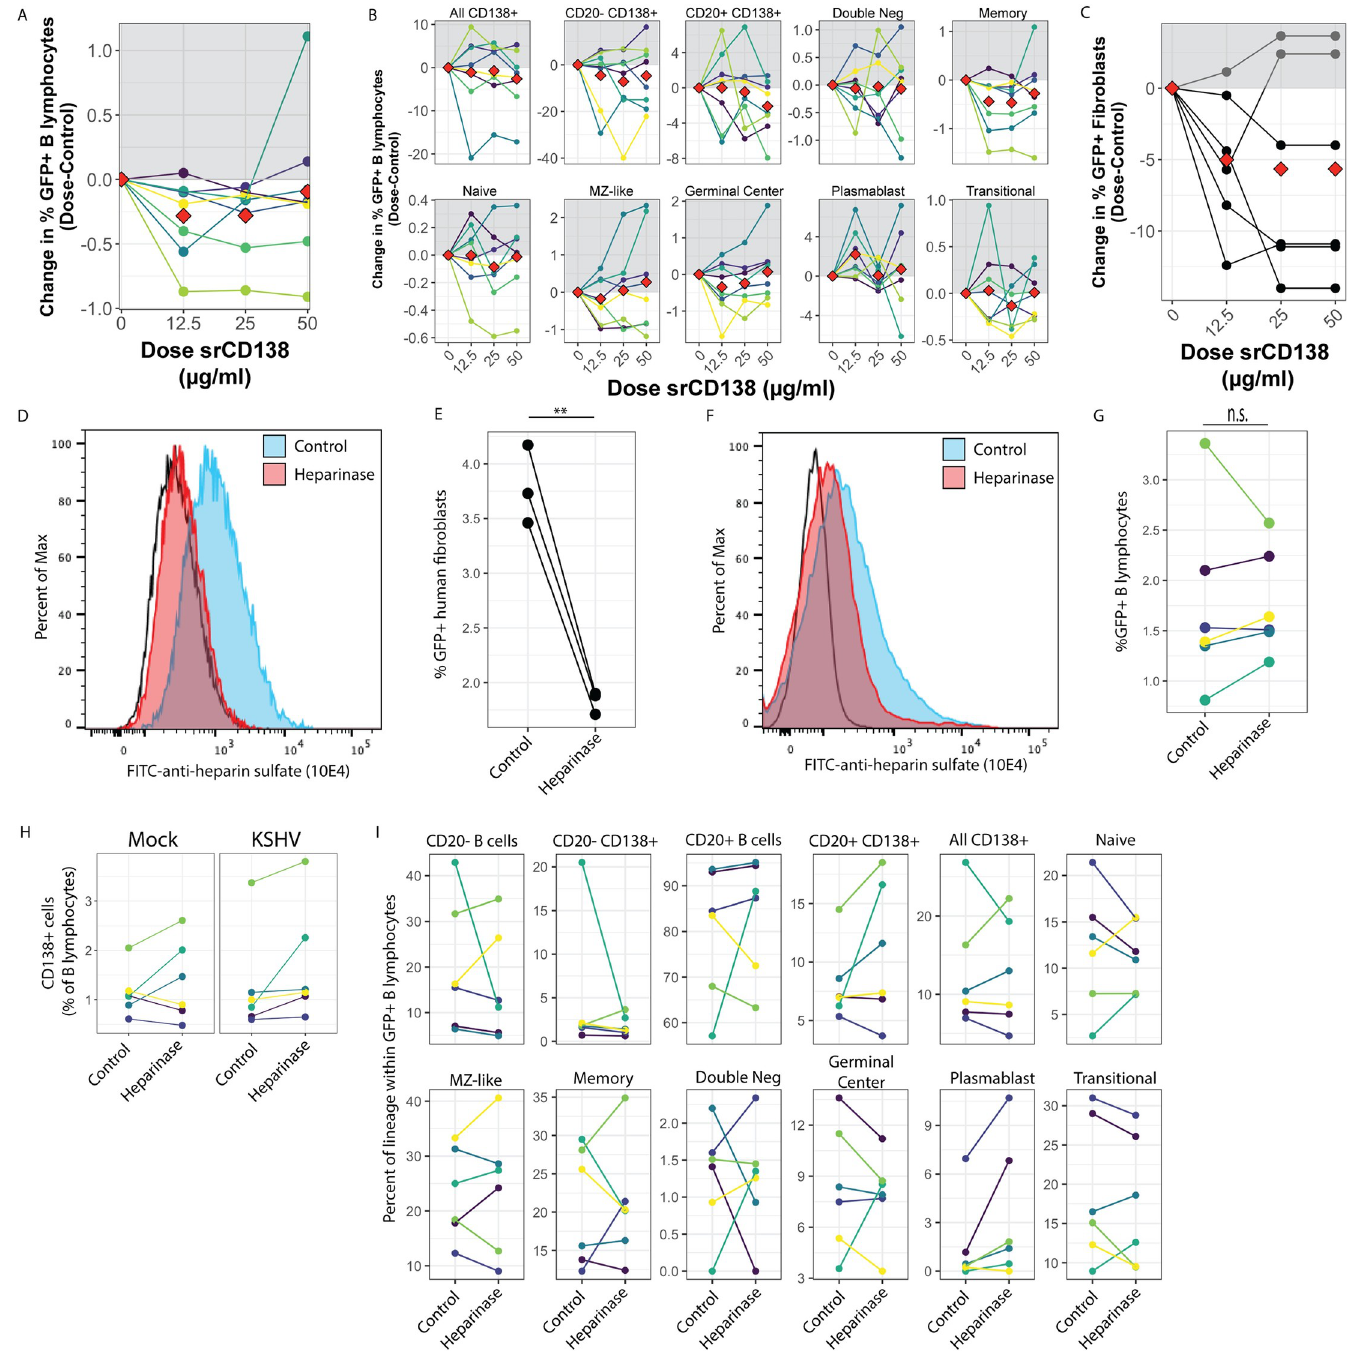
Fig 4. CD138 and heparin sulfate proteoglycans as attachment factors for KSHV in B lymphocytes. (A) Purified KSHV virions were pre-treated with srCD138 protein at indicated concentrations (x-axis) and used for infection of B lymphocytes. Cells were collected at 3dpi, stained for B cell lineages as shown in S1A Fig and Table 2 and analyzed by flow cytometry for lineage frequencies and KSHV infection by GFP reporter expression. 8 experimental replicates of 5 unique tonsil specimens are shown where the average infection rate was 1.8 ± 0.5% in untreated controls. Data is represented as change in GFP+ cells at each dose of srCD138 compared to untreated control. Colors denote individual experimental replicates and red diamonds are the mean change at each dose for all replicates. (B) Data as in (A) for within- subset GFP quantitation. (C) Similar experiments were performed in E6/E7 transformed fibroblasts derived from human tonsils. 6 experimental replicates are shown where the average infection rate was 25.5 ± 16% in untreated controls. Data is represented as change in GFP+ cells as in (A). (D) 1 million E6/E7 transformed human tonsil fibroblasts were treated with 4.5 units of heparinase I/III blend for 24 hours and removal of heparin sulfate proteoglycans was verified by flow cytometry using a heparin sulfate-FITC antibody. Black line indicates no antibody control. (E) Control (untreated) or heparinase-treated fibroblasts were infected with KSHV.219 and